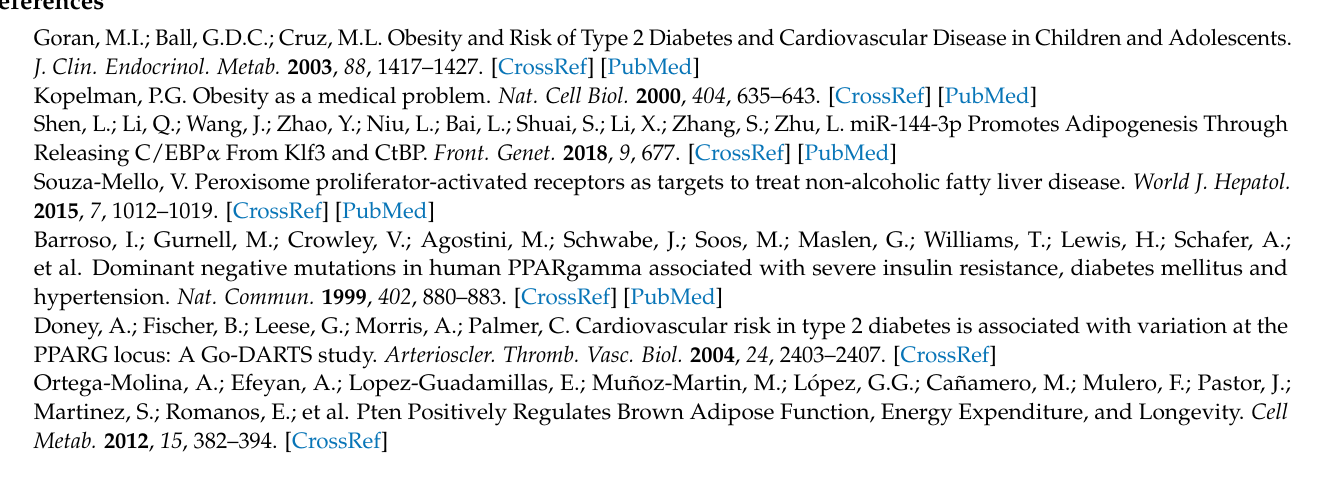
.figshare.16436838, Supplementary Table S1: The sequence used in the whole